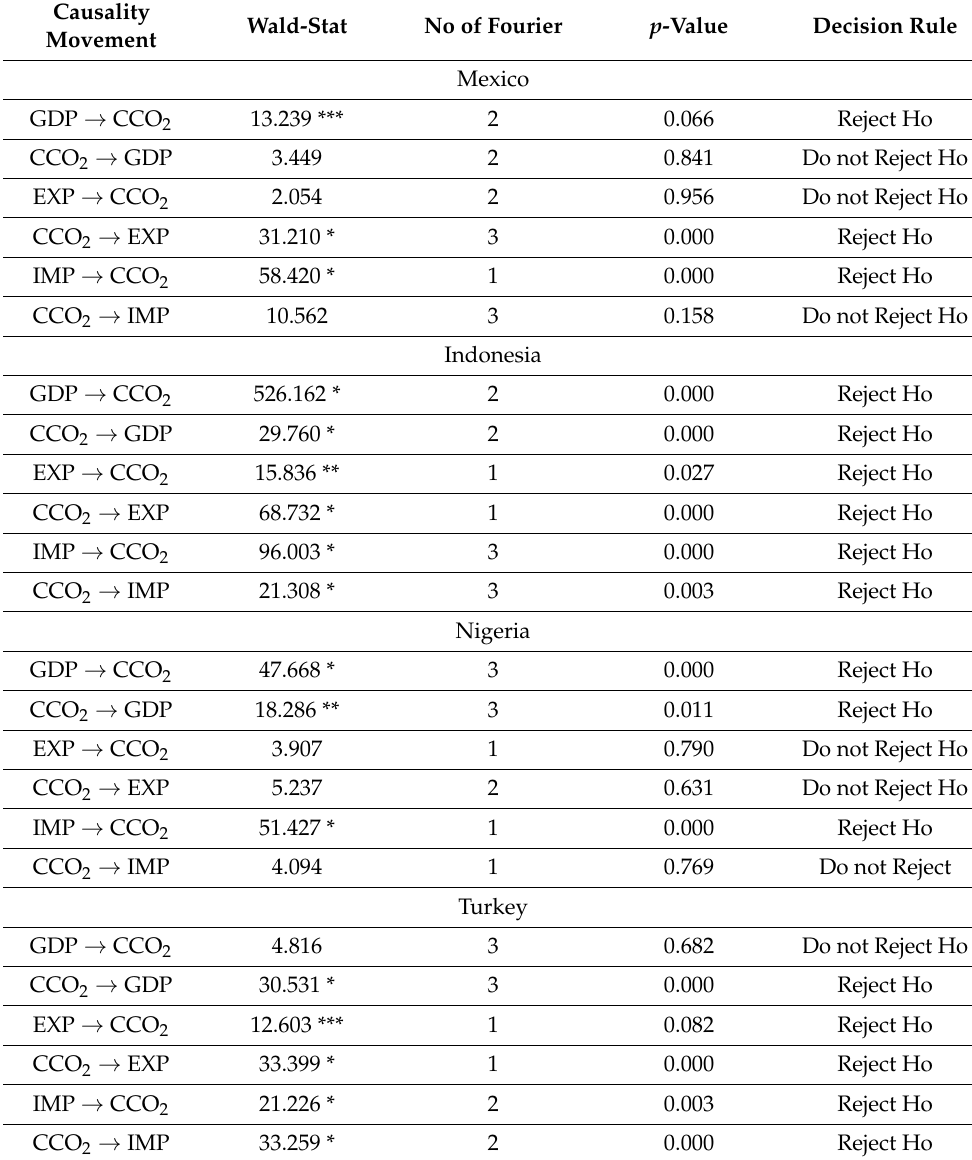
Table 9. Gradual Shift Causality